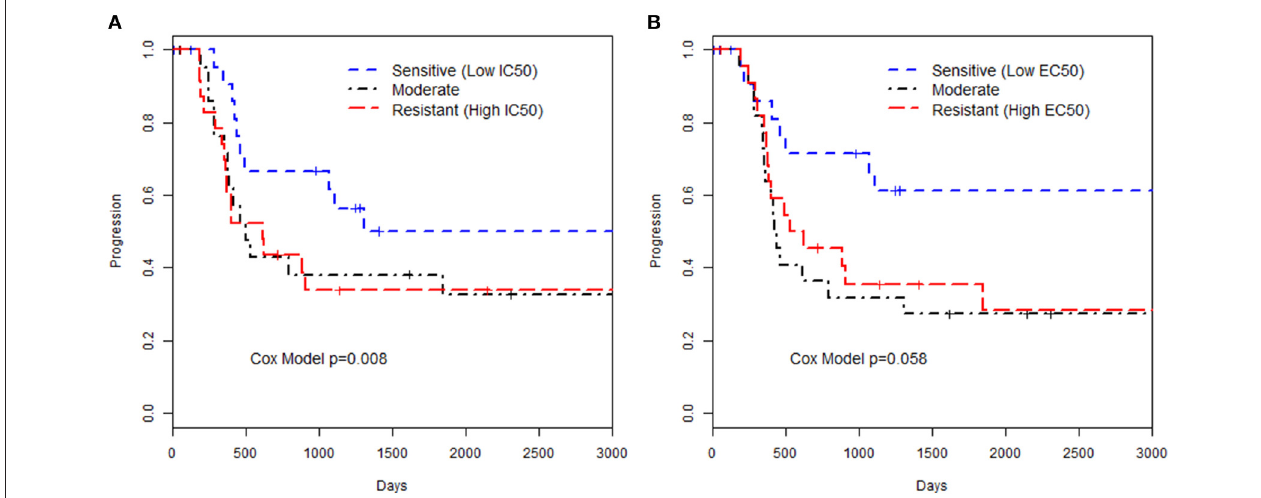
FIGURE 1 | Kaplan-Meier curves for time to progression and paclitaxel in vitro phenotypes. The groupings were defined by 3 quartiles representing low, medium or high values for the phenotype based (A) MTT assay IC50 or (B) Caspase 3/7 EC50 assay. The p -value presented is from a Cox proportional hazards model with the in vitro phenotype modeled as a continuous measurement on the log-scale.